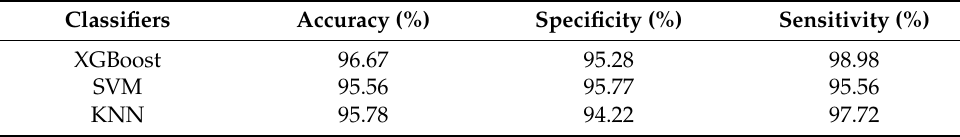
Table 2. Performance